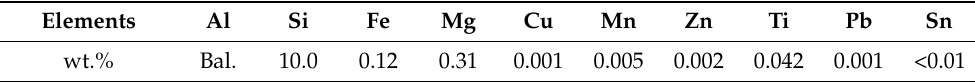
Table 1. Chemical composition of AlSi10Mg samples